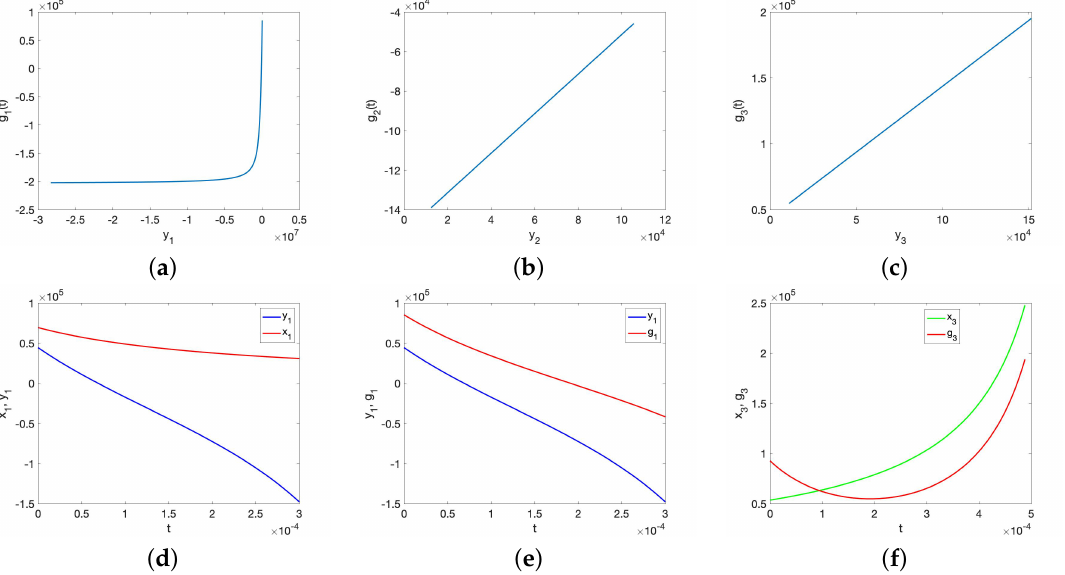
Figure 6. No GS with large initial data. ( a ) y 1 − g 1 plot showing no 1:1 correlation. ( b ) y 2 − g 2 plot showing no 1:1 correlation. ( c ) y 3 − g 3 plot showing no 1:1 correlation. ( d ) Simulation showing time evolution for x 1 and y 1 . ( e ) Simulation showing time evolution for g 1 and y 1 . ( f ) Time series plot showing blow-up occurring in x 3 and estimated at time T ∗ ≈